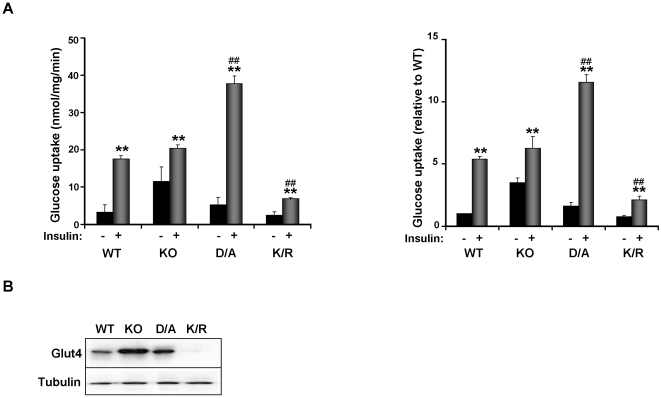
Insulin-induced glucose uptake is impaired in K/R adipocytes.
A) Differentiated KO and reconstituted cells were serum starved O/N then stimulated with insulin (100 nM) for 30 minutes followed by addition of 2-deoxy-[3H] glucose for 3 minutes. Data are expressed as nmol of glucose taken up/mg of cell protein/min (left panel) and as percentage of basal uptake in WT cells (right panel). Bar graphs are data from three independent experiments and data are presented as means ± SEM. B) Immunoblots of Glut4 expression in differentiated cells. Blots were probed with anti-Tubulin antibodies as a control for loading. (*) indicates statistically significant difference between basal and insulin-stimulated conditions in each cell type, while (#) indicates statistically significant difference between insulin-stimulated glucose uptake in KO, D/A and K/R cells compared with WT.